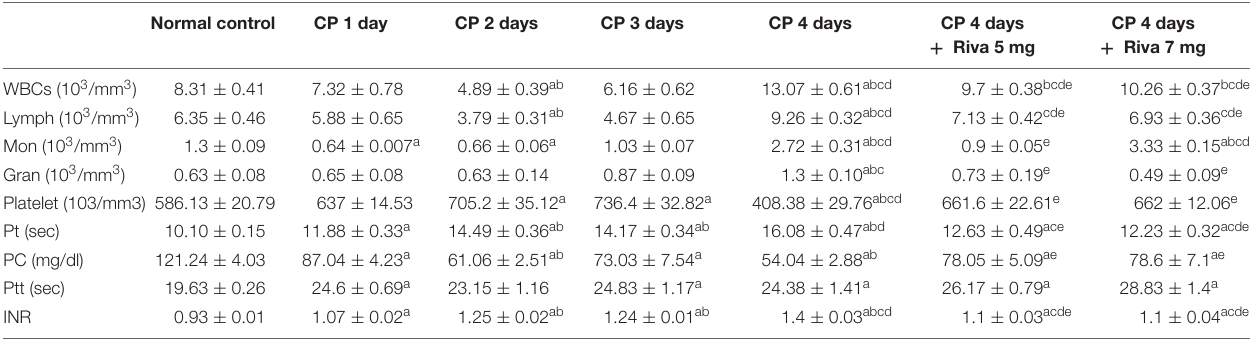
TABLE 2 | Effect of cisplatin (CP) with or without rivaroxaban (Riva) on hematological parameters (CBC and coagulation profile). Normal